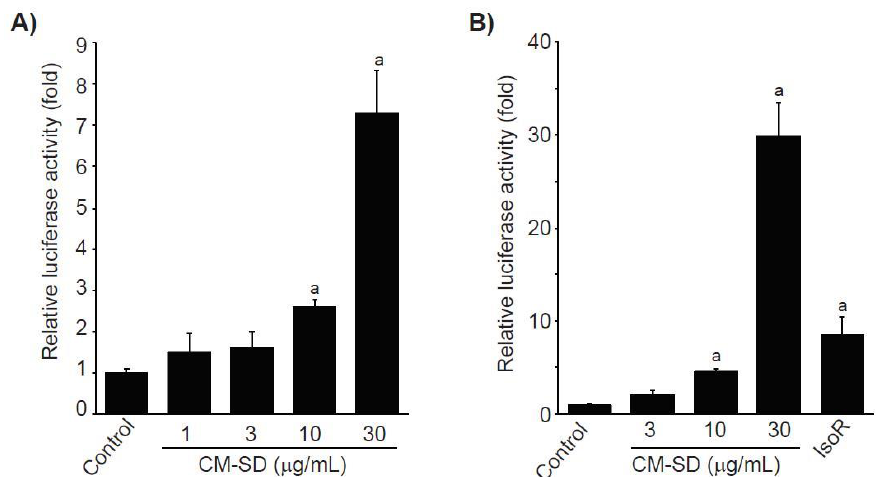
Figure 4. Effect of CM-SD on Nrf2 transactivation in recombinant HepG2 cells (which harbor ARE-driven reporter gene) ( A ) and C2C12 cells ( B ). Values are expressed as mean ± SD at least three separate experiments. Experimental data from HepG2 and C2C12 cells were analyzed by LSD and Dunnett’s T3 test, respectively. a p < 0.01, significant as compared with control.